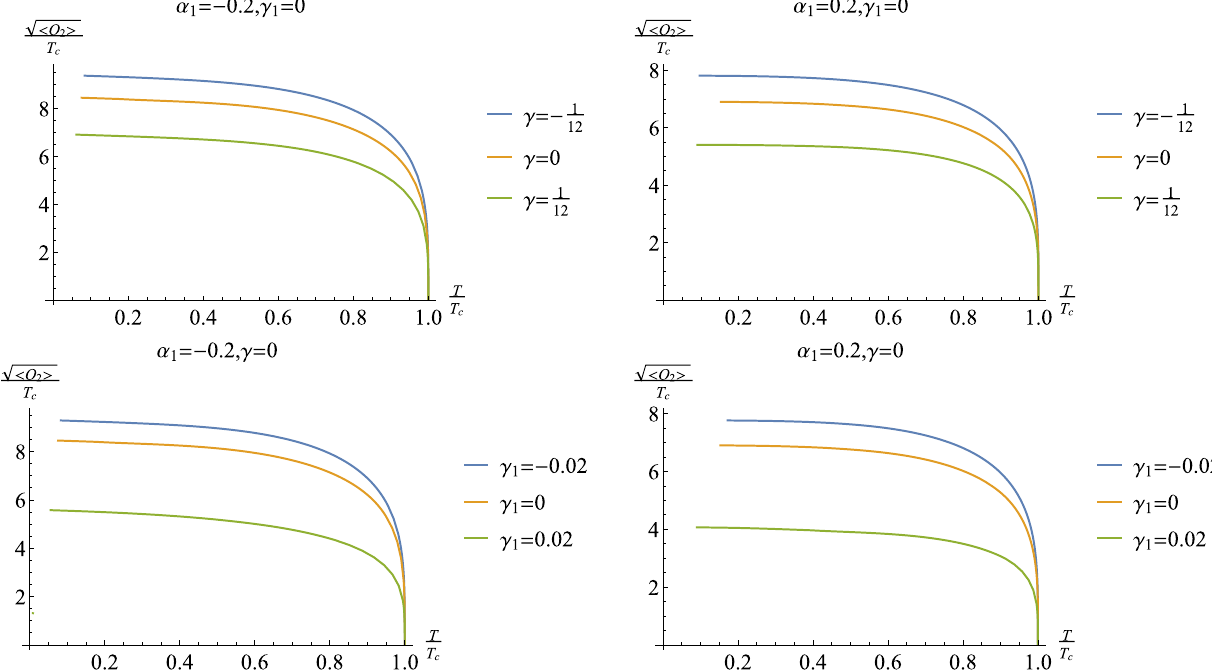
√ (cid:9) O (cid:10) / T c as a function of the temperature T 2